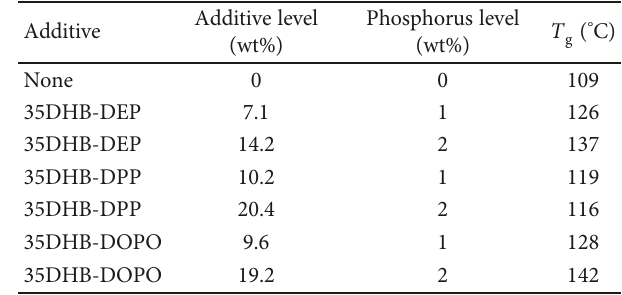
Table 6: Glass transition temperatures for blends of